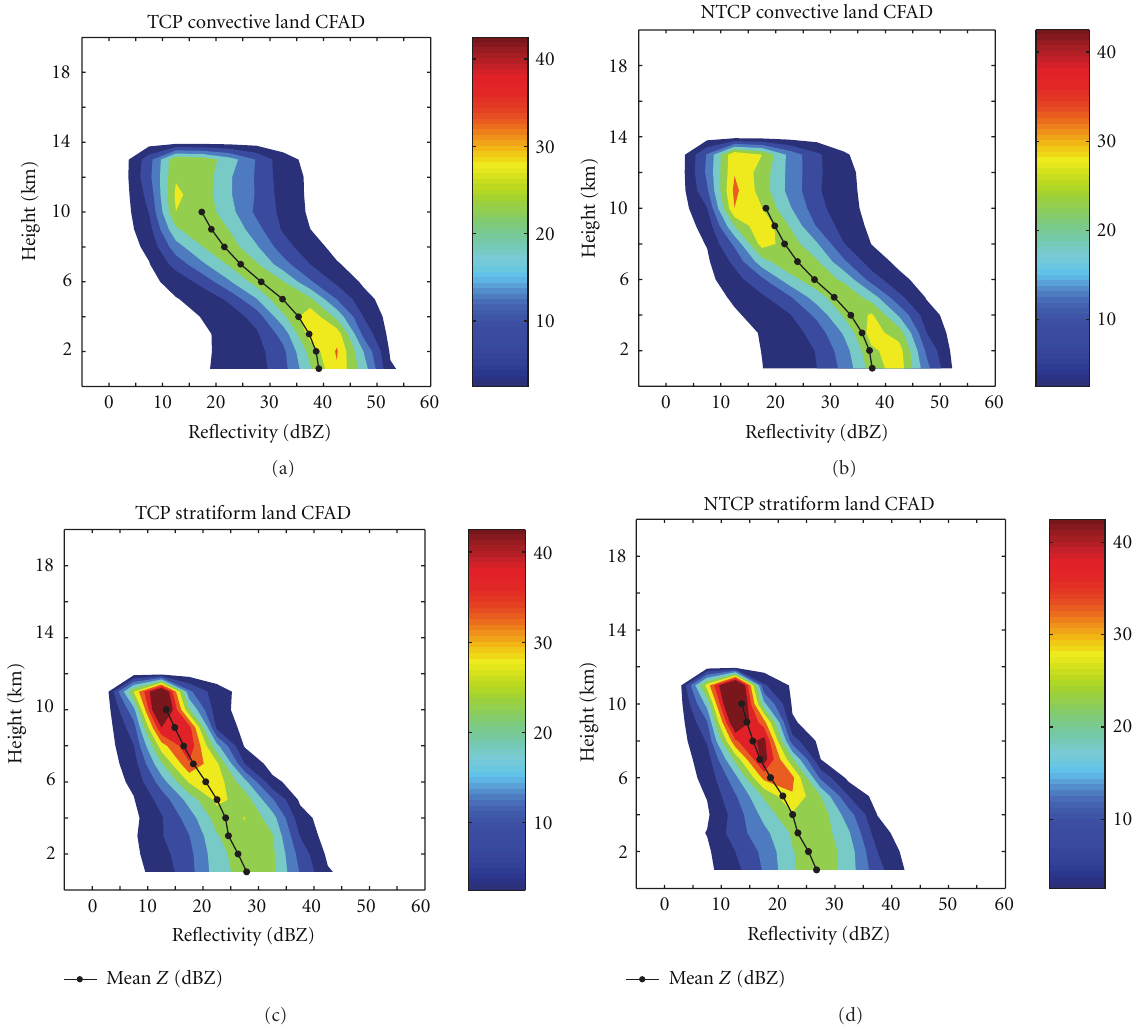
Figure 14: Mean CFADs for the convective regime over land for (a) the mean TCP event and (b) the mean NTCP event. The stratiform regime over land is shown for the mean TCP and NTCP events in (c) and (d), respectively. CFADs are contoured by the same constraints as in Figure